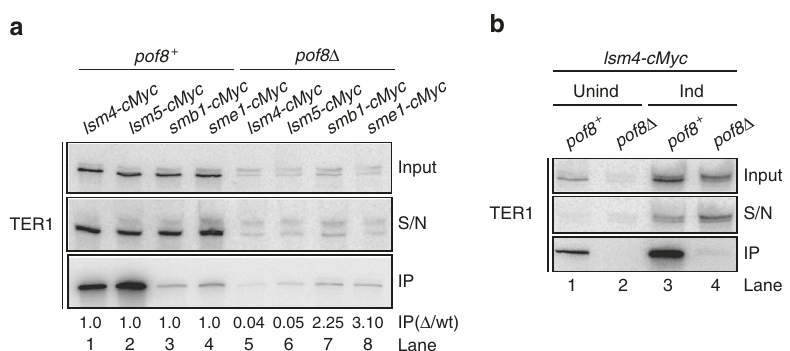
Fig. 4 Lsm2-8 complex fails to associate with TER1 in Pof8-de fi cient cells. a Northern blot analysis of TER1 following immunoprecipitation (IP) of cMyc- tagged Lsm and Sm proteins. Input and supernatant (S/N) represent 10% of the IP samples. Upper band corresponds to precursor, lower band to mature form. IP signal was normalized to precursor plus mature form from the input samples and fold enrichment is shown relative to wildtype below the blots. The uncropped blots are presented in Supplementary Fig. 3c. b Northern blot analysis of TER1 from anti-cMyc IP samples. Strains contain plasmid borne, inducible TER1 in an Lsm4-cMyc background. Input and S/N represent 10% of the IP samples (Unind uninduced, Ind induced). The uncropped blots are presented in Supplementary Fig.